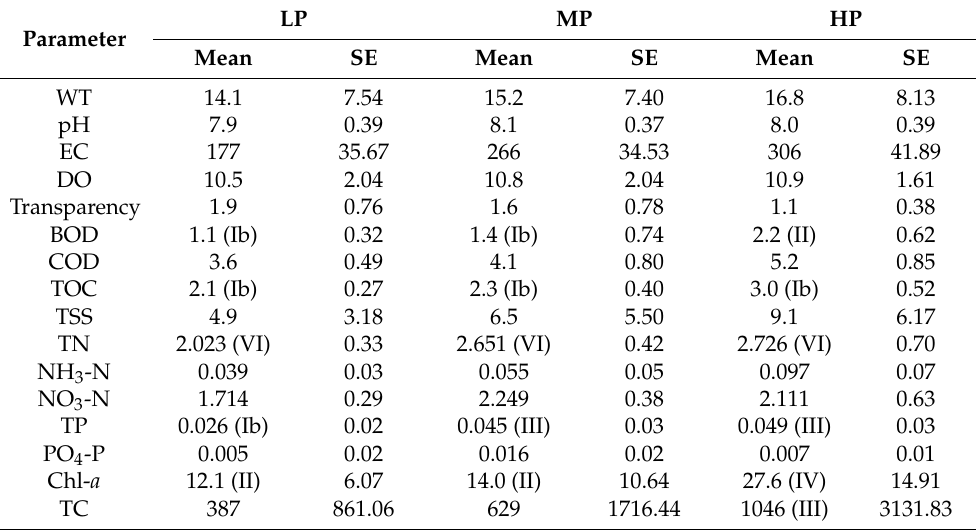
Table 4. Mean values with standard error (SE) and ANOVA for water quality parameters in clusters of the sampling